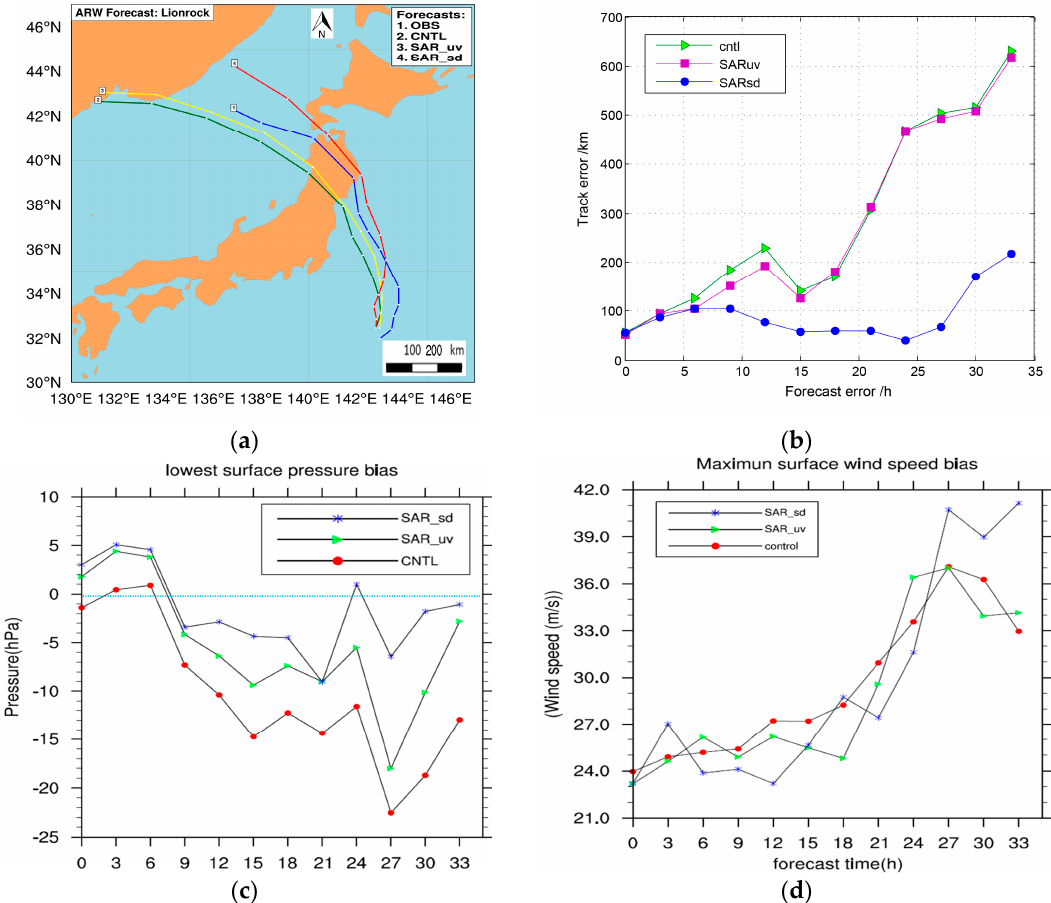
Figure 8. For Typhoon Lionrock: ( a ) 33h track forecast initialized at 0900 UTC August 2016; ( b ) mean absolute track errors; ( c ) mean absolute maximum wind speed errors; ( d ) minimum sea level pressure as a function of forecast lead time.